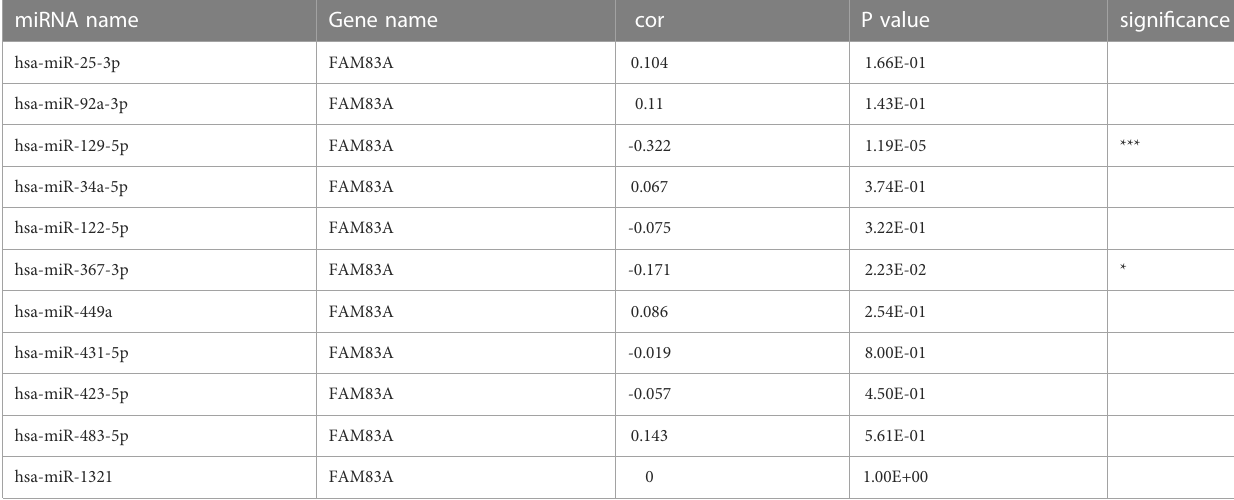
TABLE 1 Correlation analyses between candidate miRNA and